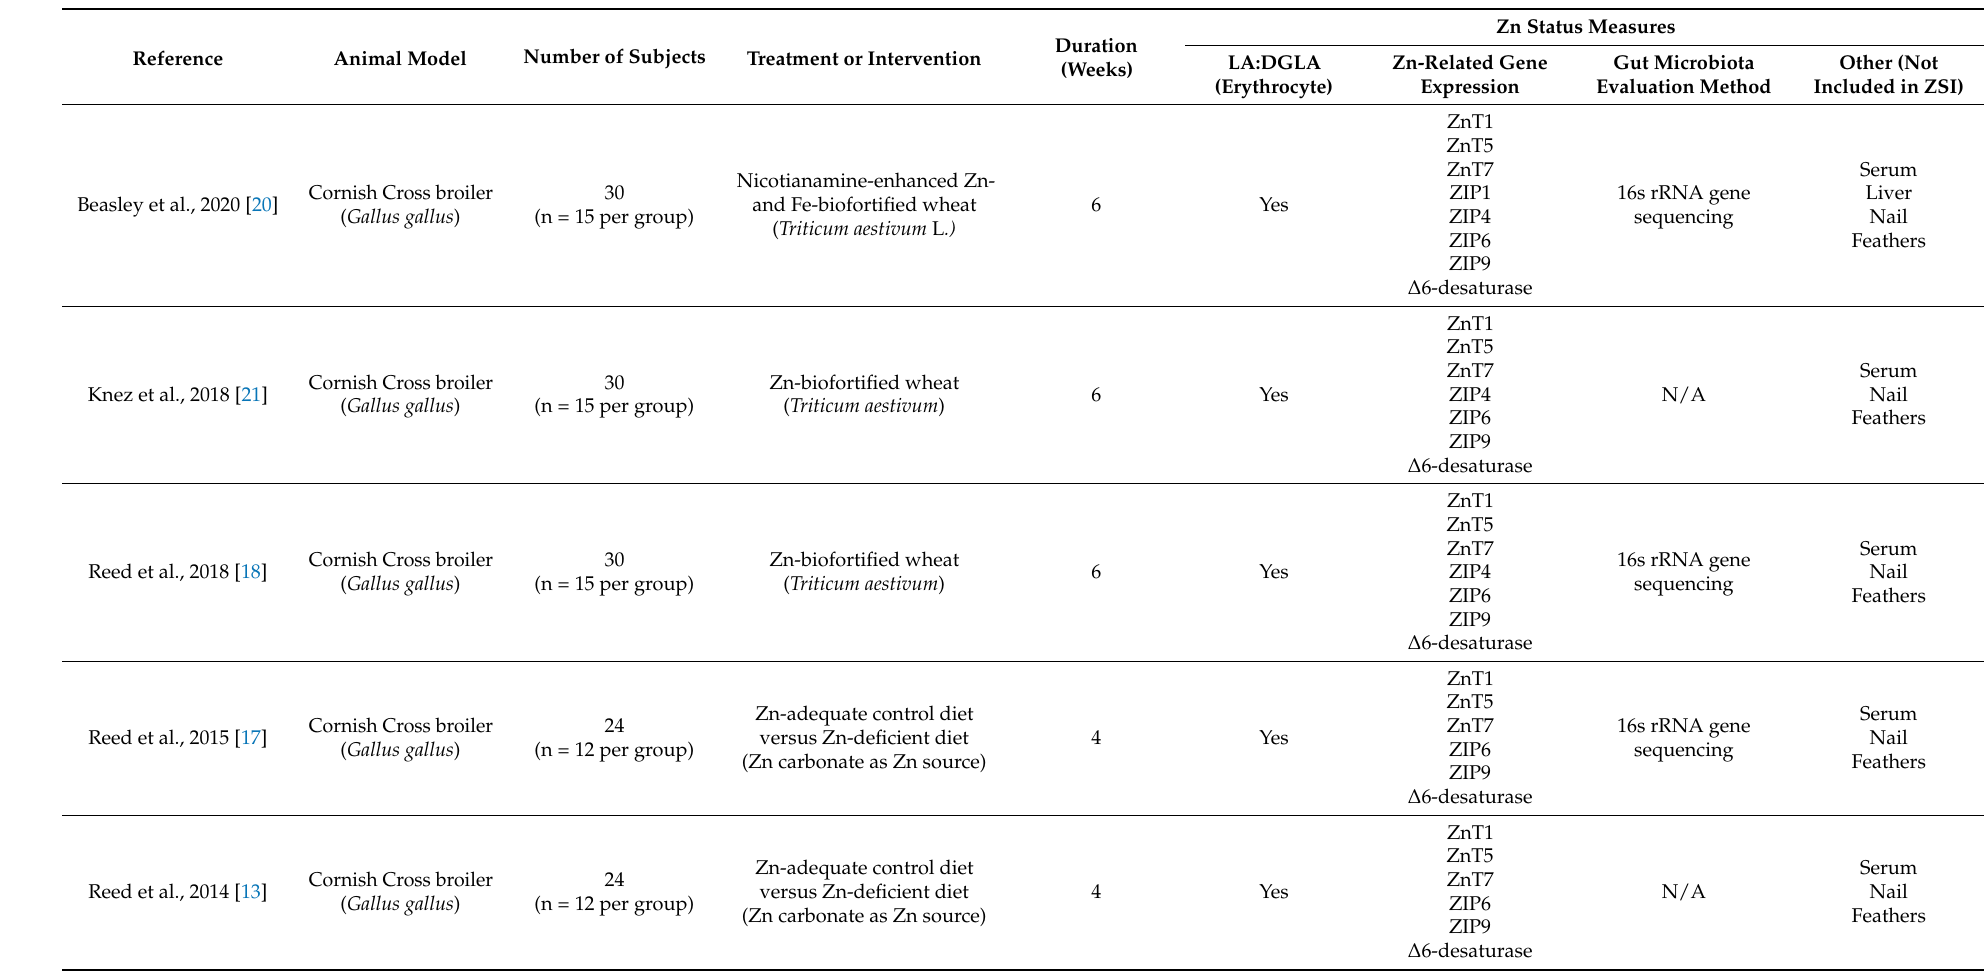
Table 2. Characteristics and methods of studies assessed for the ZSI: LA:DGLA, Zn-related gene expression, and Zn status effects on gut microbiota